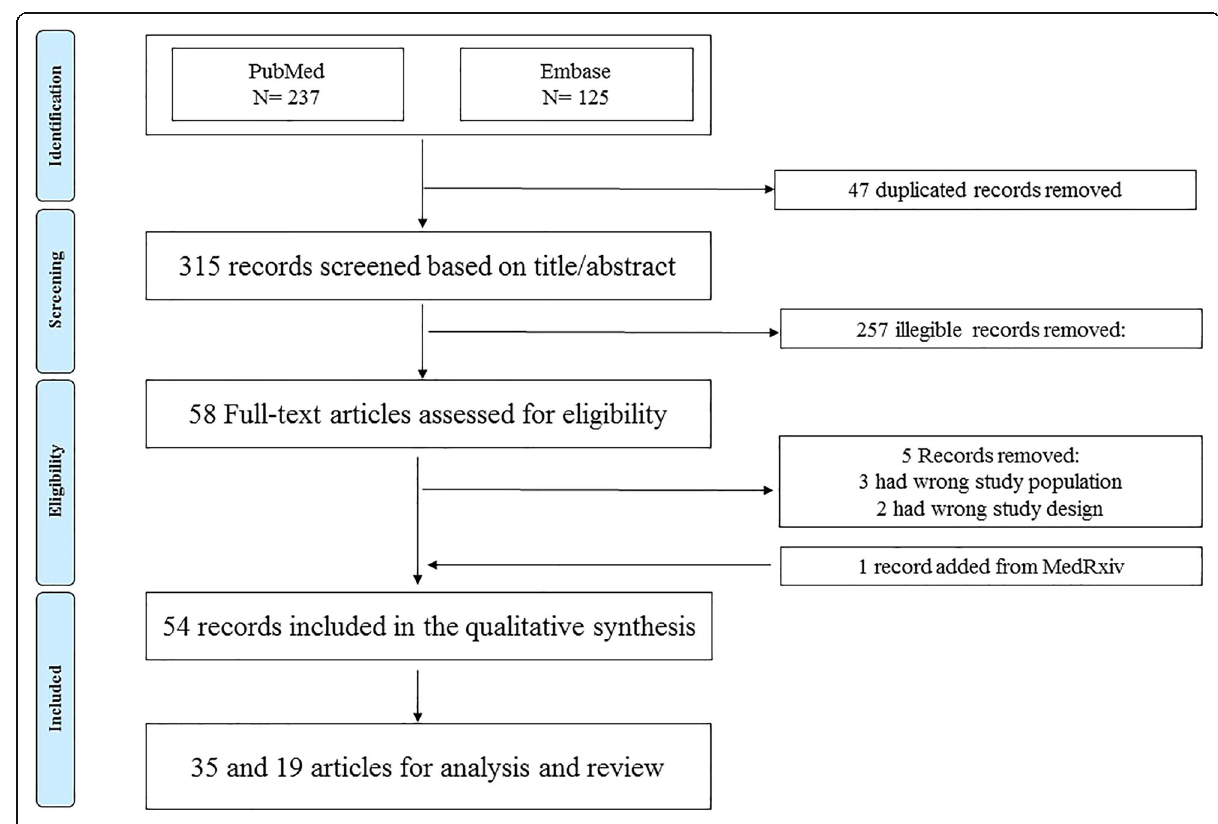
Fig. 1 PRISMA Flowchart of data